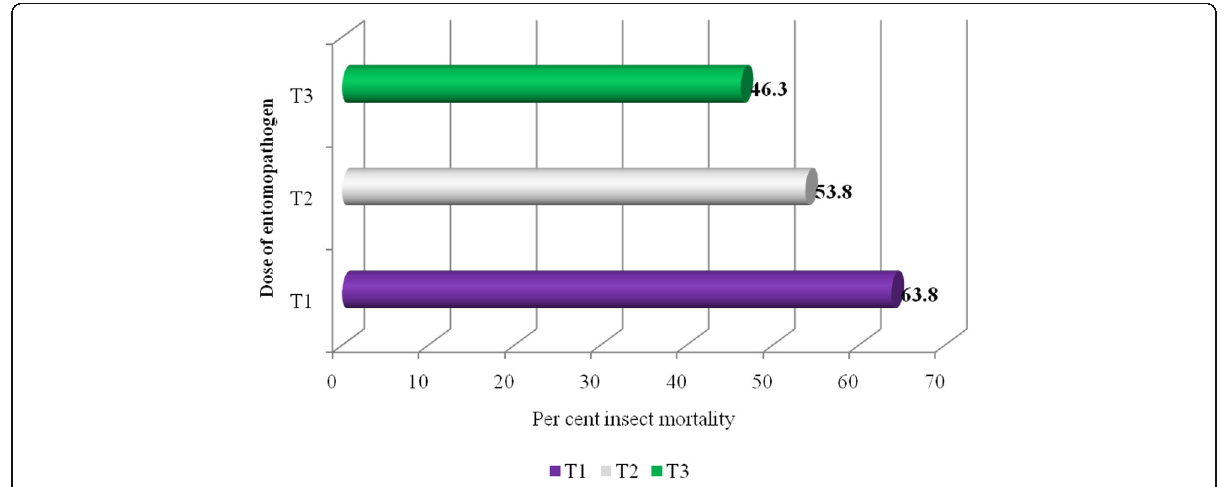
Fig. 1 Pathogenicity of Metarhizium anisopliae against red spider mite